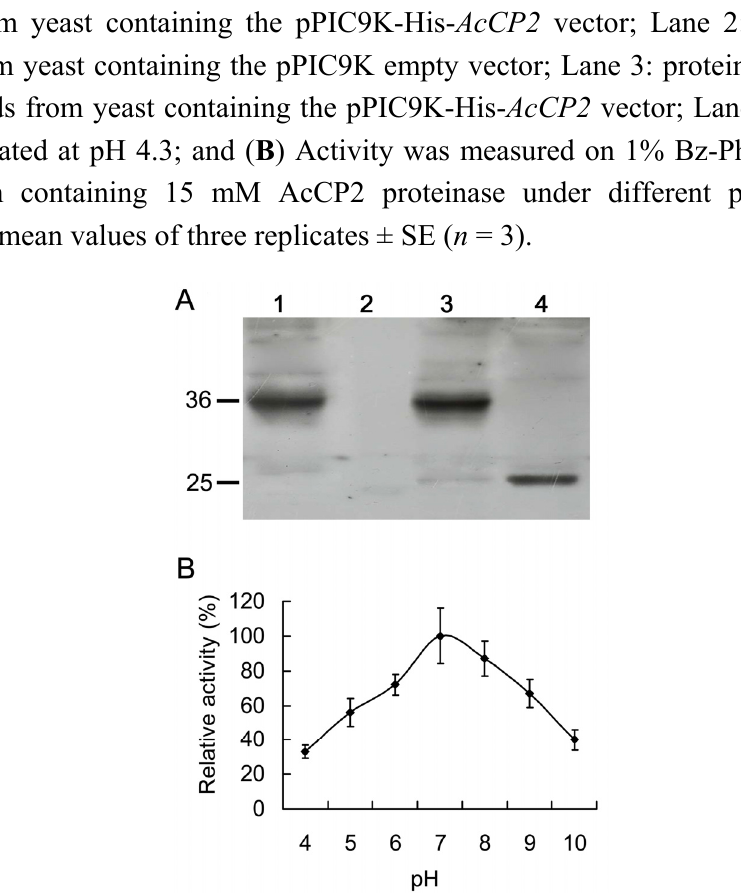
) and catalytic rate constants ( k m